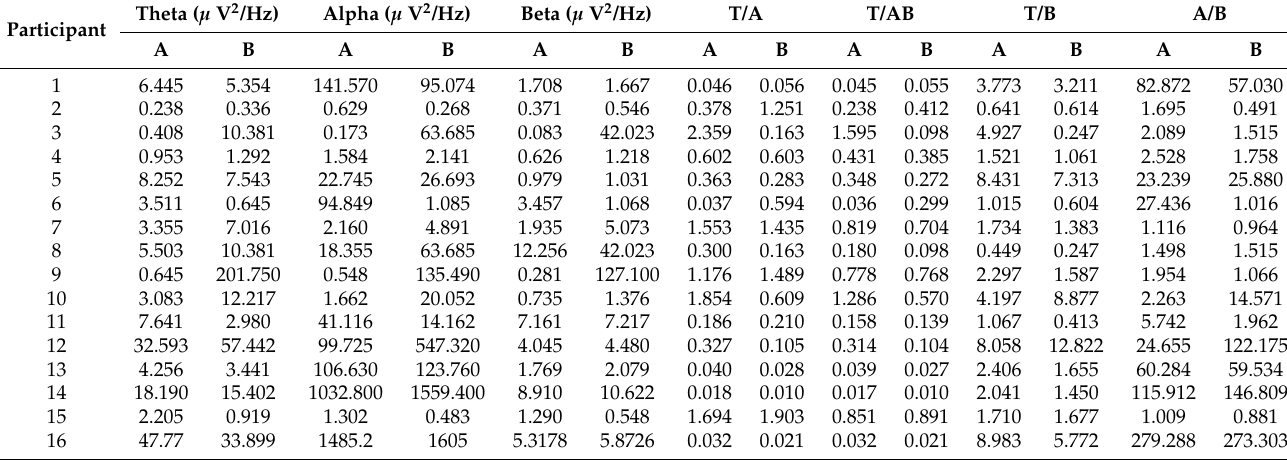
Table 1. EEG indices in Experiment